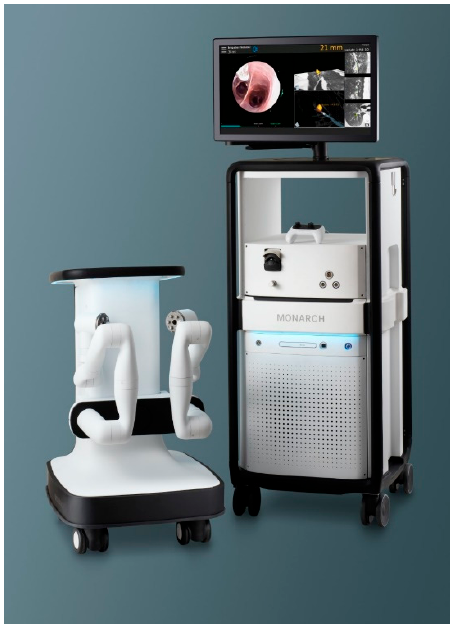
Figure 1. Monarch ® Robotic-Assisted Bronchoscopy Platform by Auris Health. Before the procedure, a CT is obtained with which virtual 3D reconstruction is gen- erated. Potential pathways are mapped (manually or automatically) and uploaded to the robot. Patients lay within an electromagnetic field, allowing for the use of ENB for navi- gation purposes. The operator can control the bronchoscope with a handheld controller, not unlike that of a gaming controller. Once the target is reached, the location can be verified with fluoroscopy or rEBUS before the entire bronchoscope system is locked to maintain its static position while biopsies are